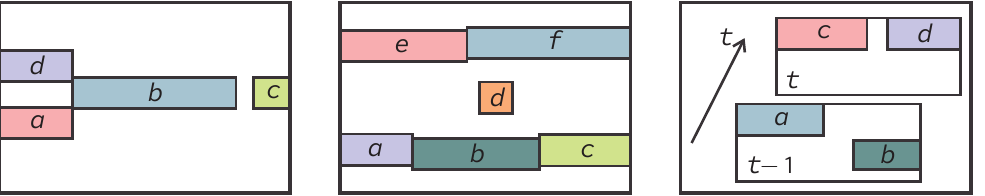
Figure 6. Defining the neighbors: horizontal neighbors (left image), valid neighbors are a-b, d-b; vertical neighbors (middle image), valid neighbors are a-e, b-e, b-d, b-f, c-f, d-f; (right image) temporal neighbors, valid neighbors are